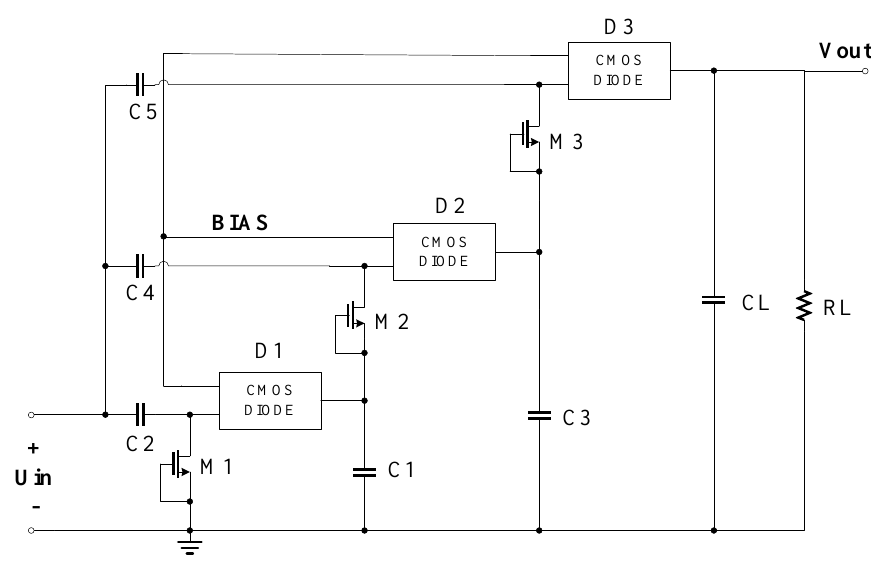
Figure 10. A improved 3-stage charge pump rectifier.